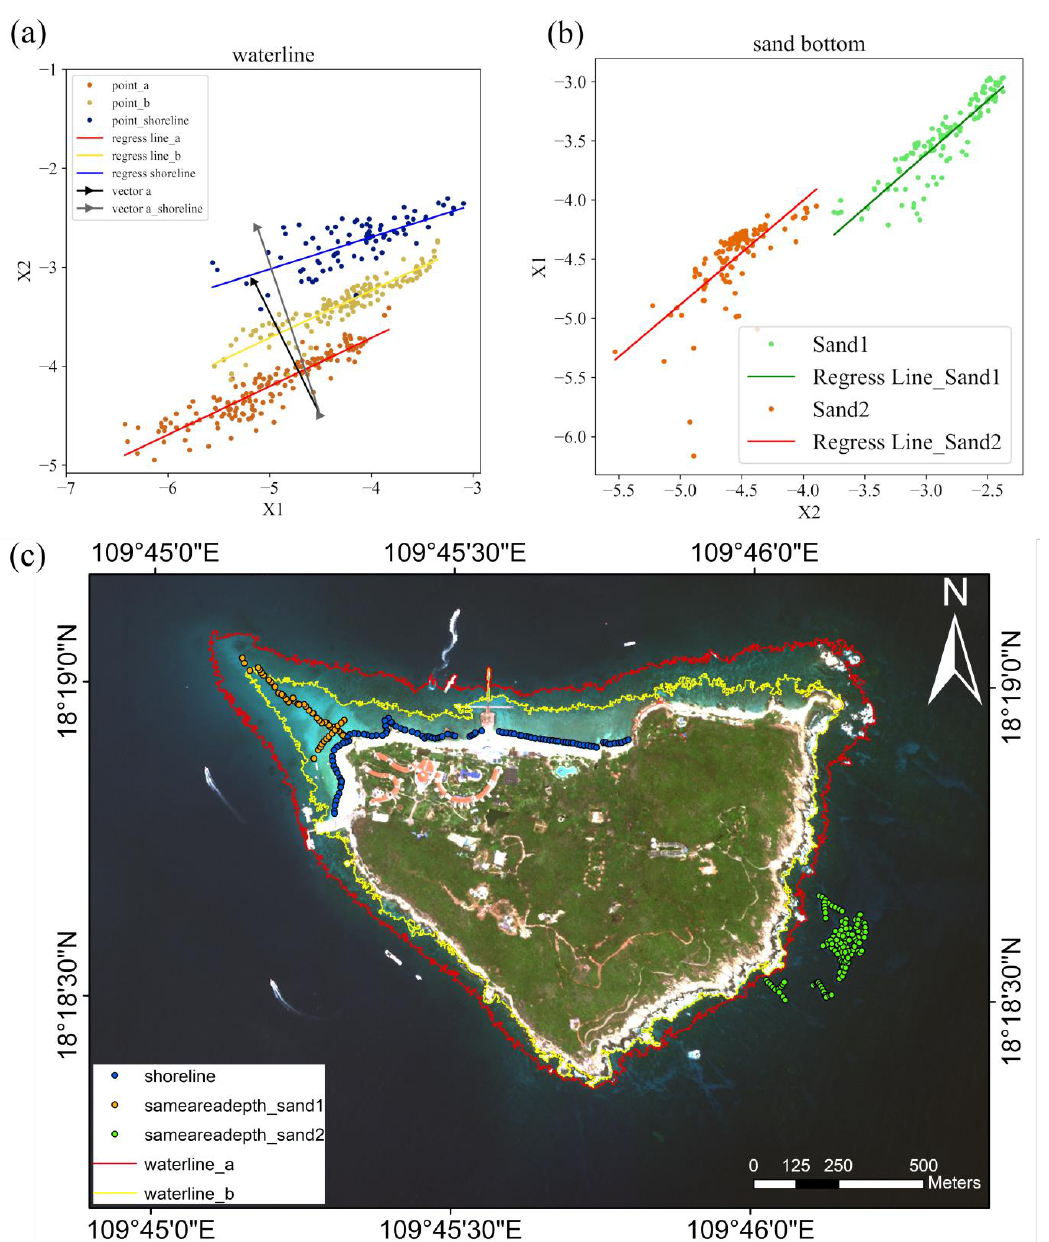
Figure 7. ( a ) Linear regression function for the same water depth. ( b ) Linear regression function g1/g2 for the same substrate type. ( c ) Isobath of water depth and point selection.